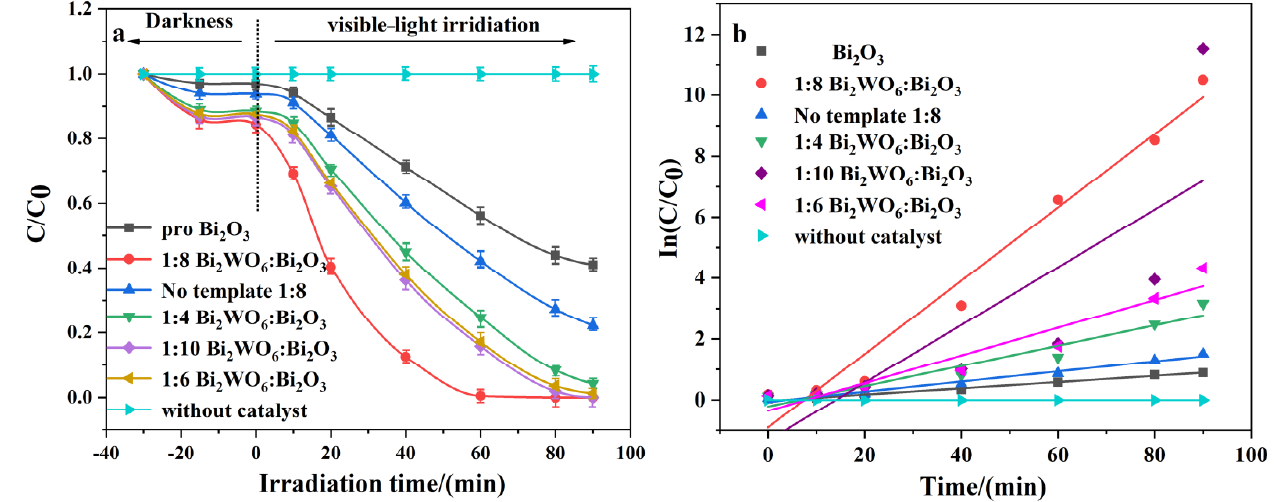
Figure 7. Photocatalytic activity to 20 mg/L TCH by 0.4 g catalyst ( a ); primary reaction kinetic curves for degradation processes ( b ).